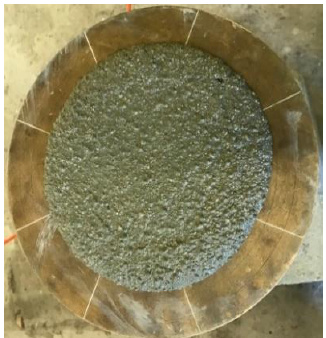
Figure 6. Flow table test. Table 4. Flow results of mixes.